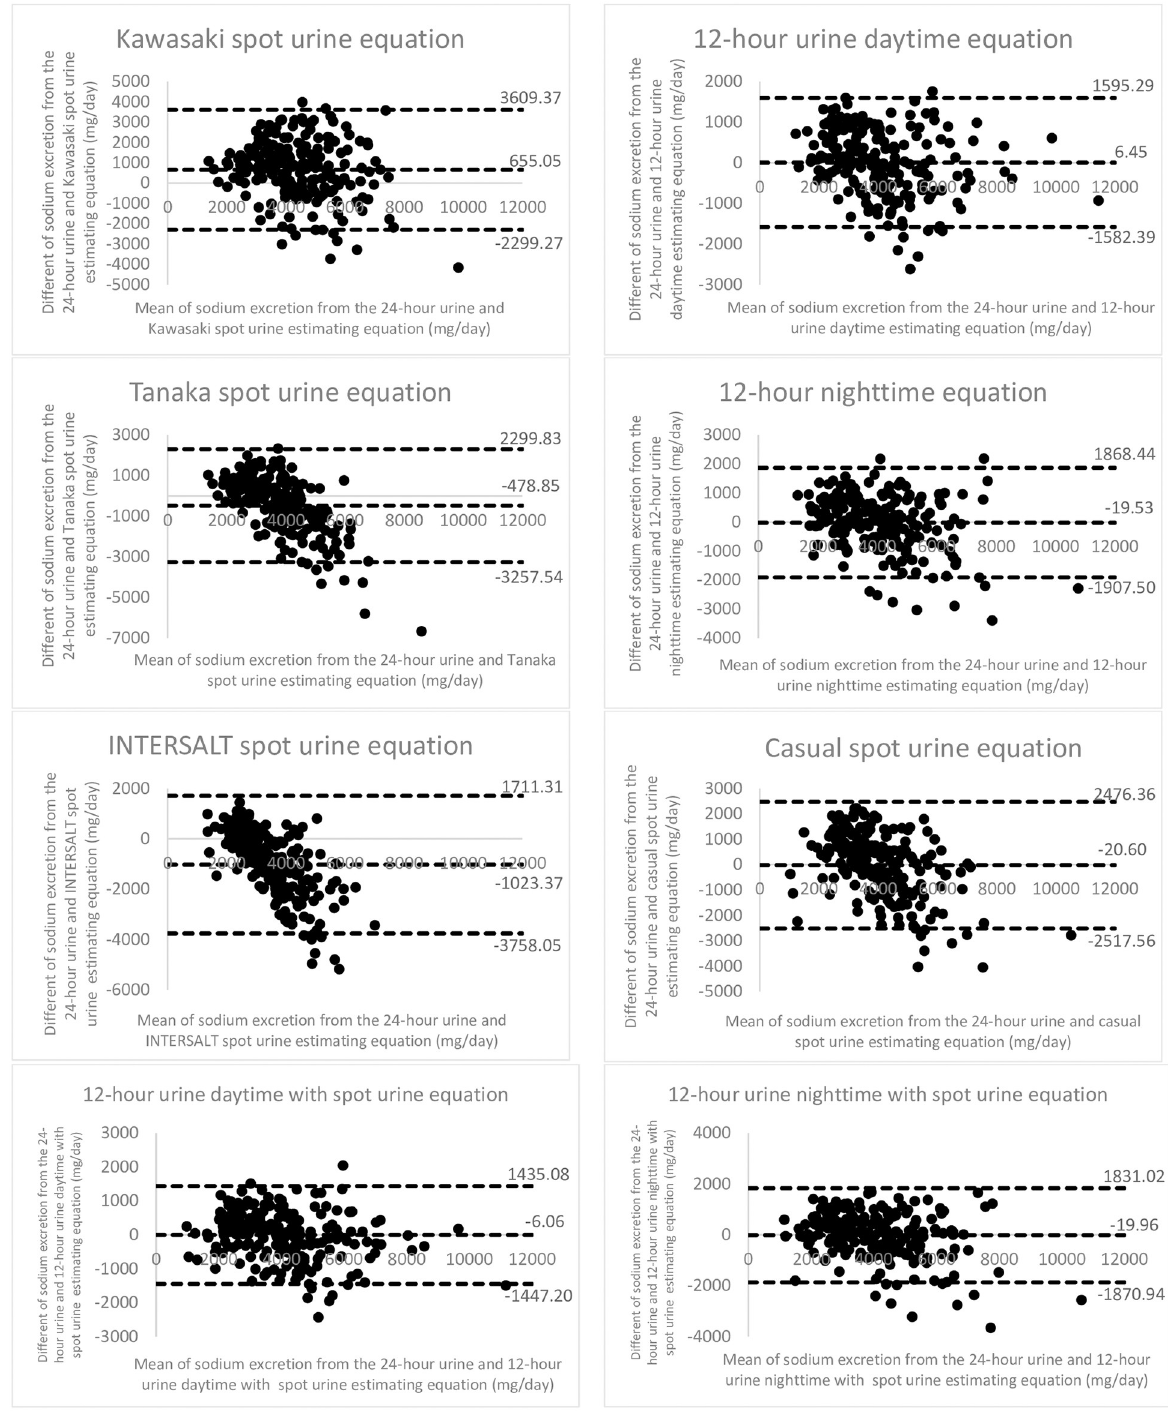
Fig 3. Bland-Altman plot: The difference between 24-hour urine sodium excretion and estimated urine sodium from novel equations. The dashed middle line represents the mean difference or bias. The other two dashed lines represents the 95% limits of agreement of the mean difference ± 1.96 standard